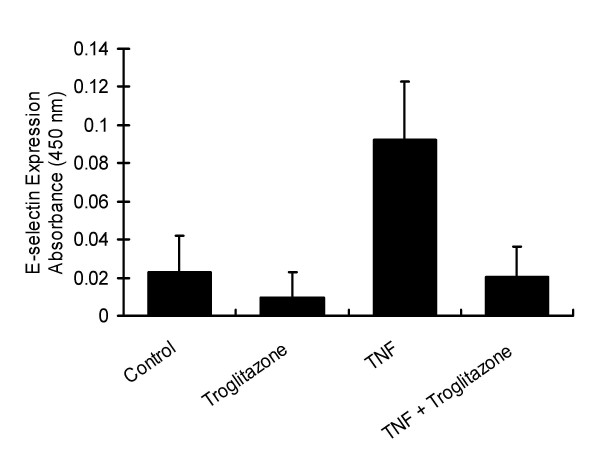
TNF-α induced E-selectin protein expression is reduced by troglitazone, a PPAR-γ ligand. TNF-α (1 ng/ml, 24 h) induced E-selectin expression was blocked by the PPAR-γ ligand, troglitazone at 20 μM (Fig. 5). Alone, this compound had no effect on the expression of E-selectin (Fig. 5).